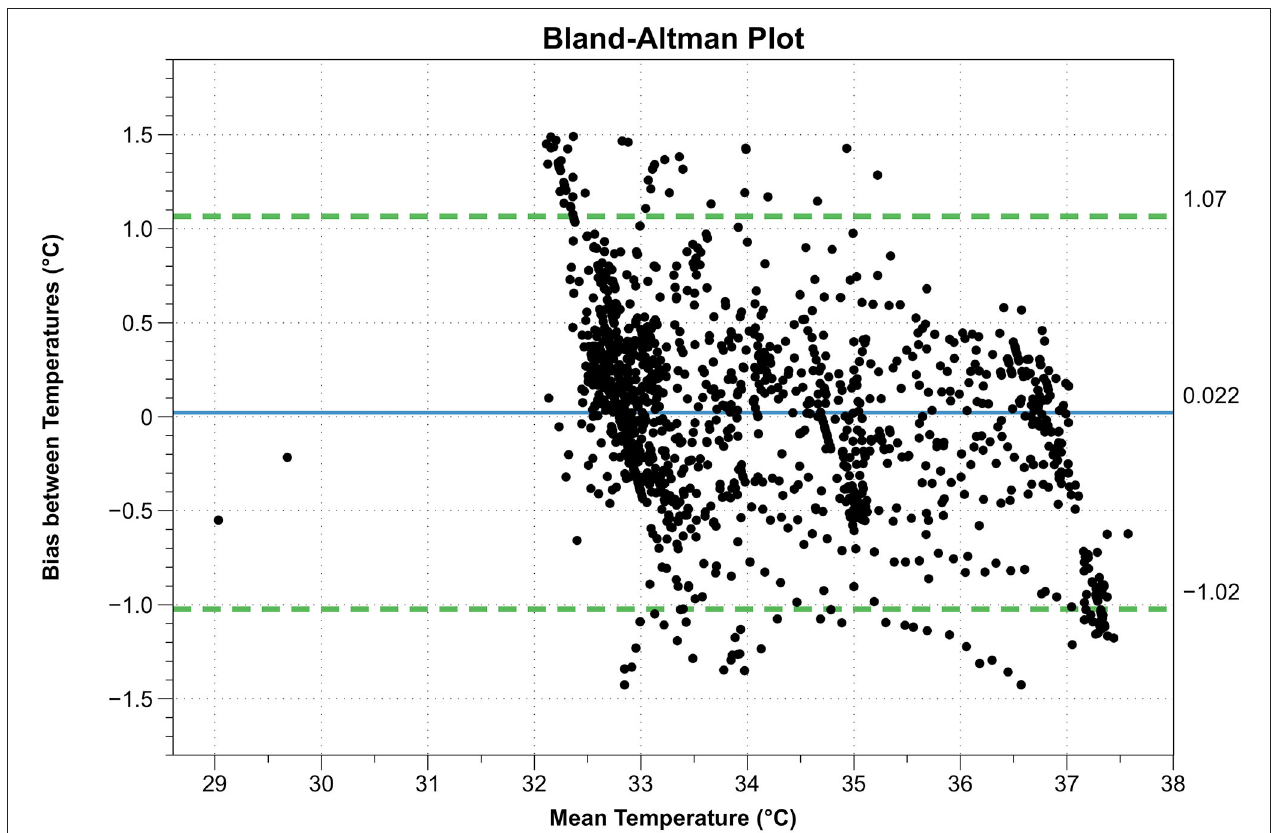
FIGURE 4 | Bland-Altman plot. X-axis: mean temperature between esophagus thermometer and double sensor, Y-axis: difference between esophagus thermometer and double sensor, continuous blue line: mean difference between esophagus thermometer and double sensor, dashed green lines: limits of agreement ( = mean difference ± 1.96 standard deviations).